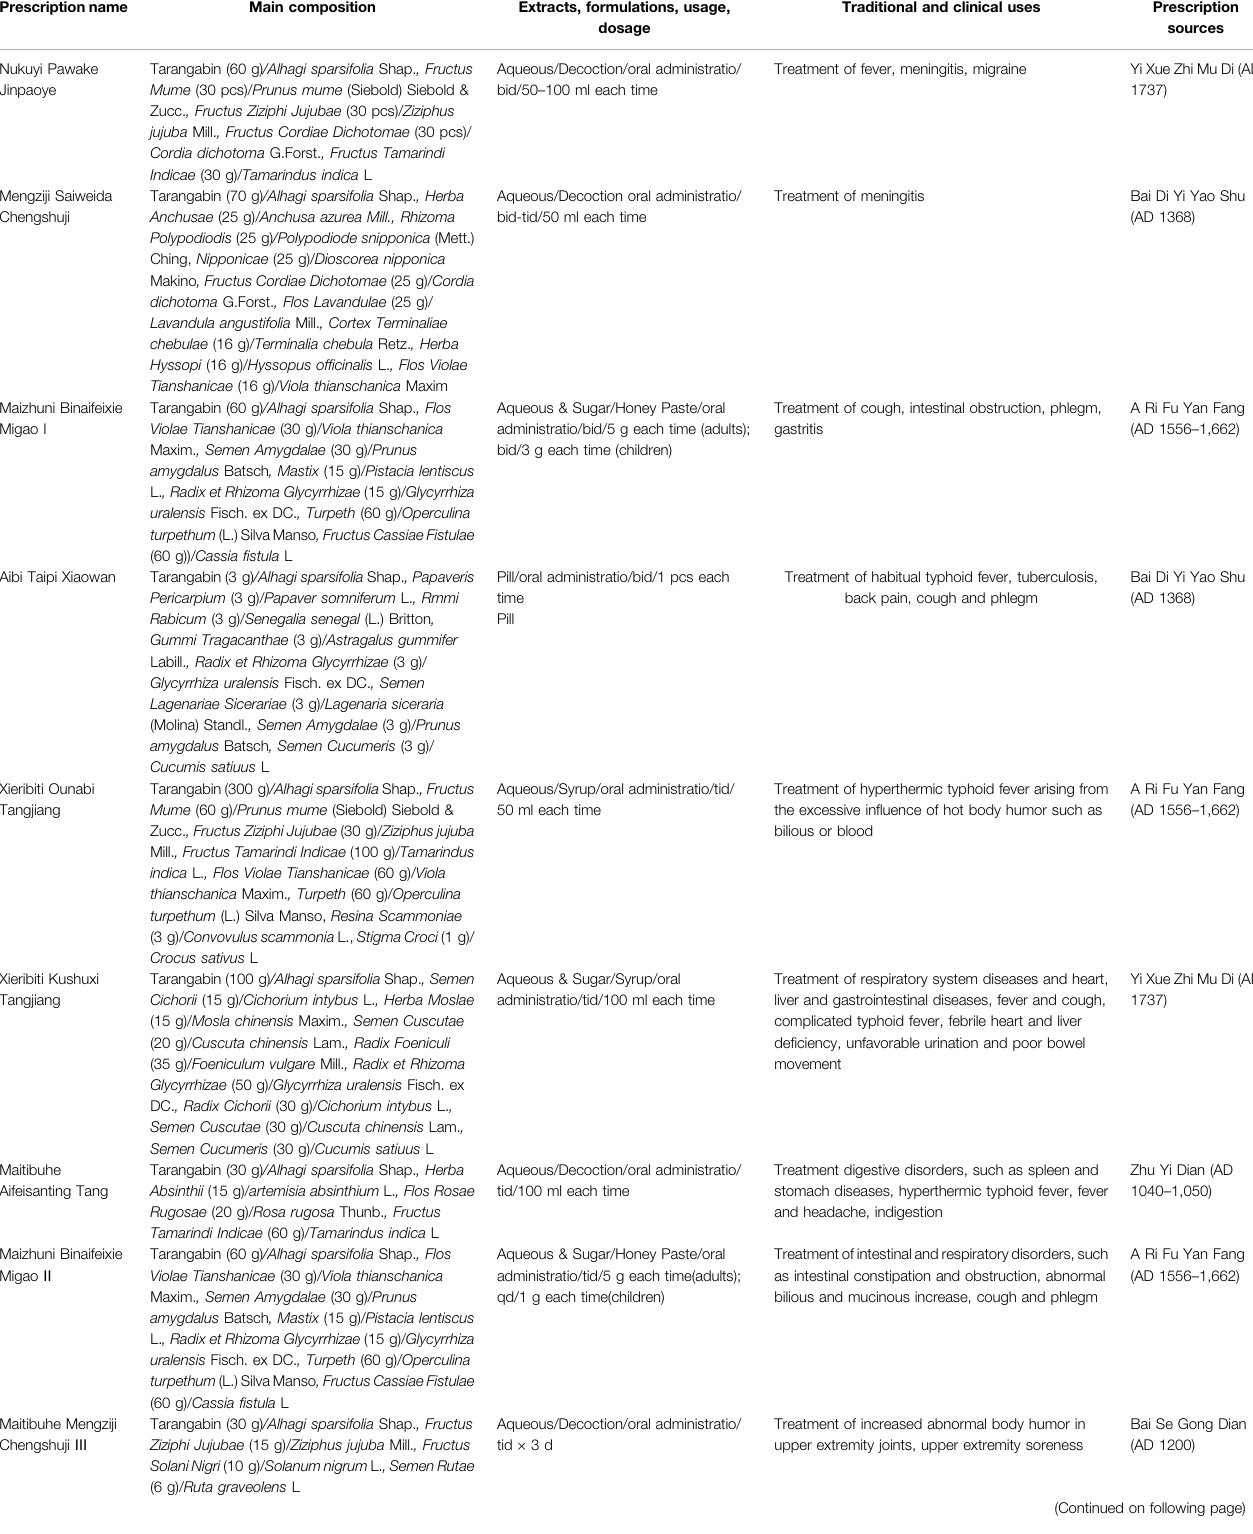
TABLE 1 | ( Continued ) The traditional use of A. sparsifolia compound prescription in